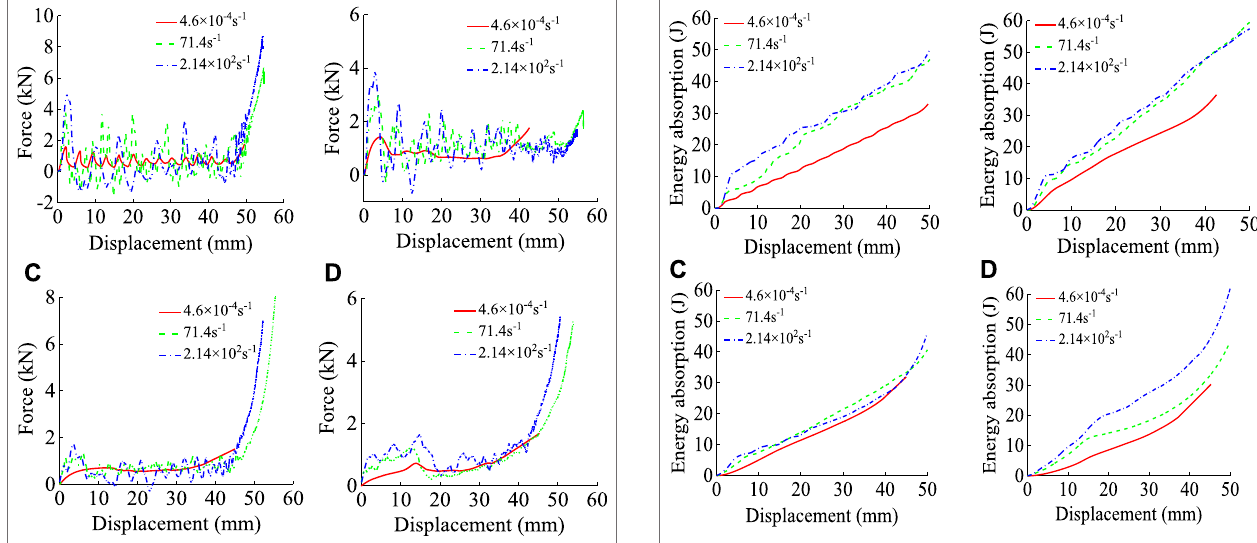
FIGURE 8 | Energy absorption-displacement curves for specimens; (A) COF0, (B) CCF1, (C) CCF2, (D) CCF3 under different strain rate.